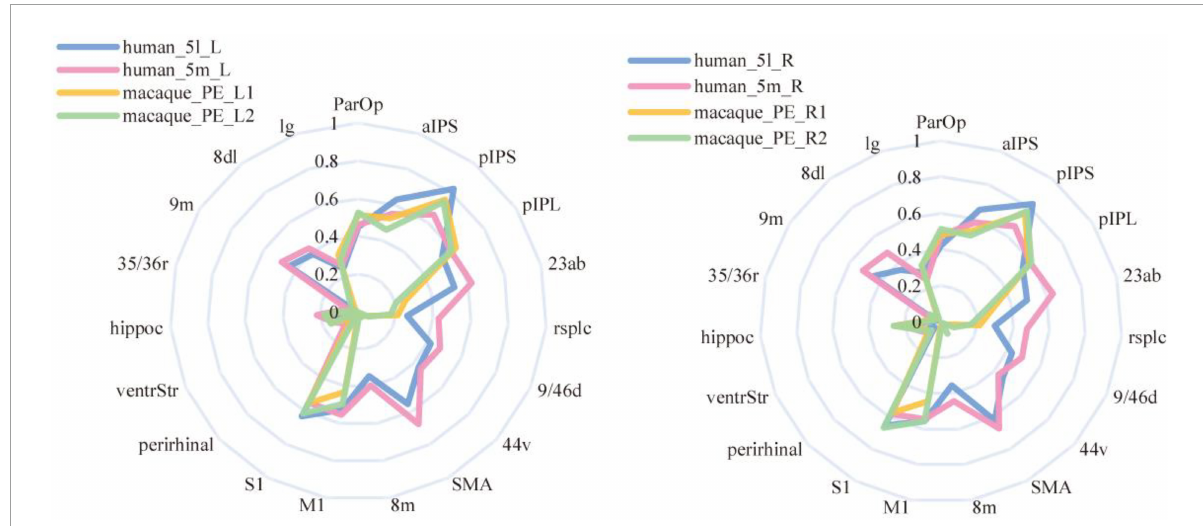
FIGURE9 Resting-state functional connectivity fingerprints of PE, 5L, and 5m. The left-hand fingerprint image shows the connections between human and macaque brain regions in the left hemisphere. The right fingerprint image shows connections between human and macaque brain regions associated with the right hemisphere.